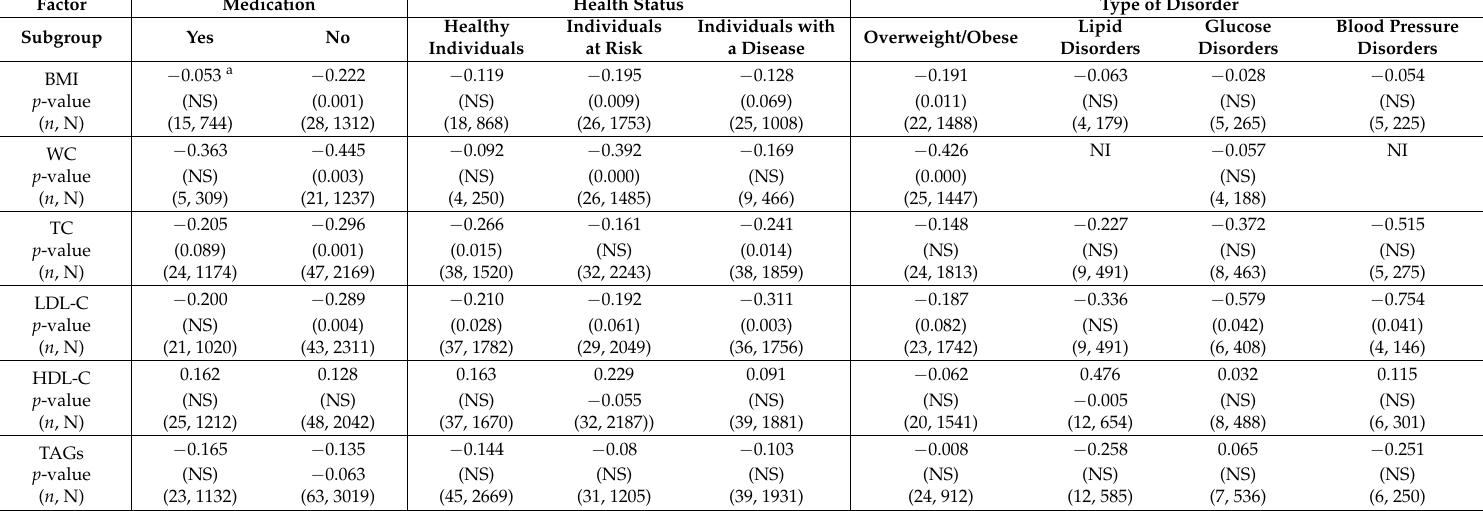
Table 4. Analysis of the influence of medication and health status on the effects (SDM) of the supplementation with flavanols on BMI, WC, and blood lipids